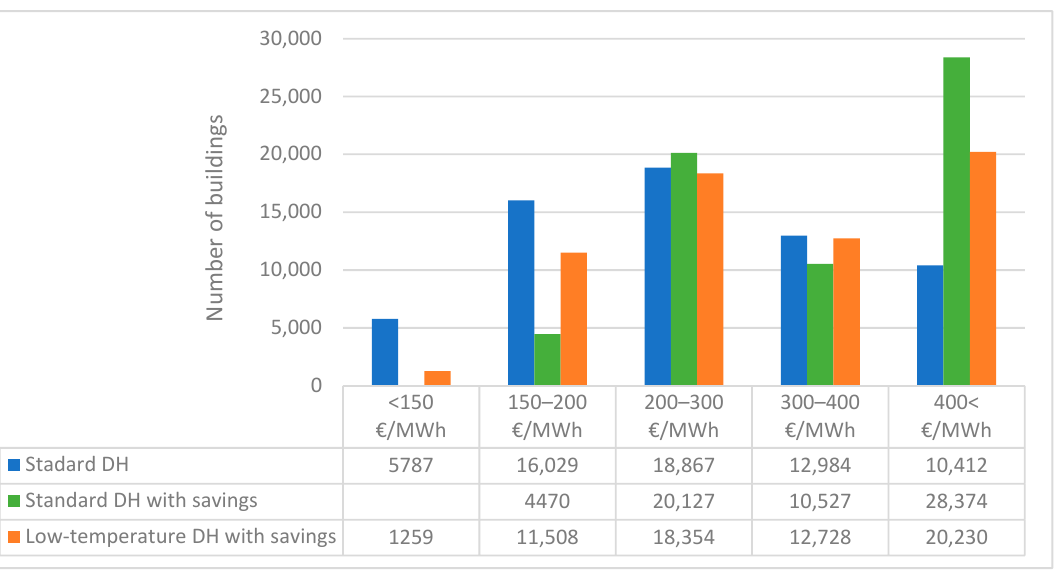
Figure 8. Heat costs for district heating expansion in three scenarios.